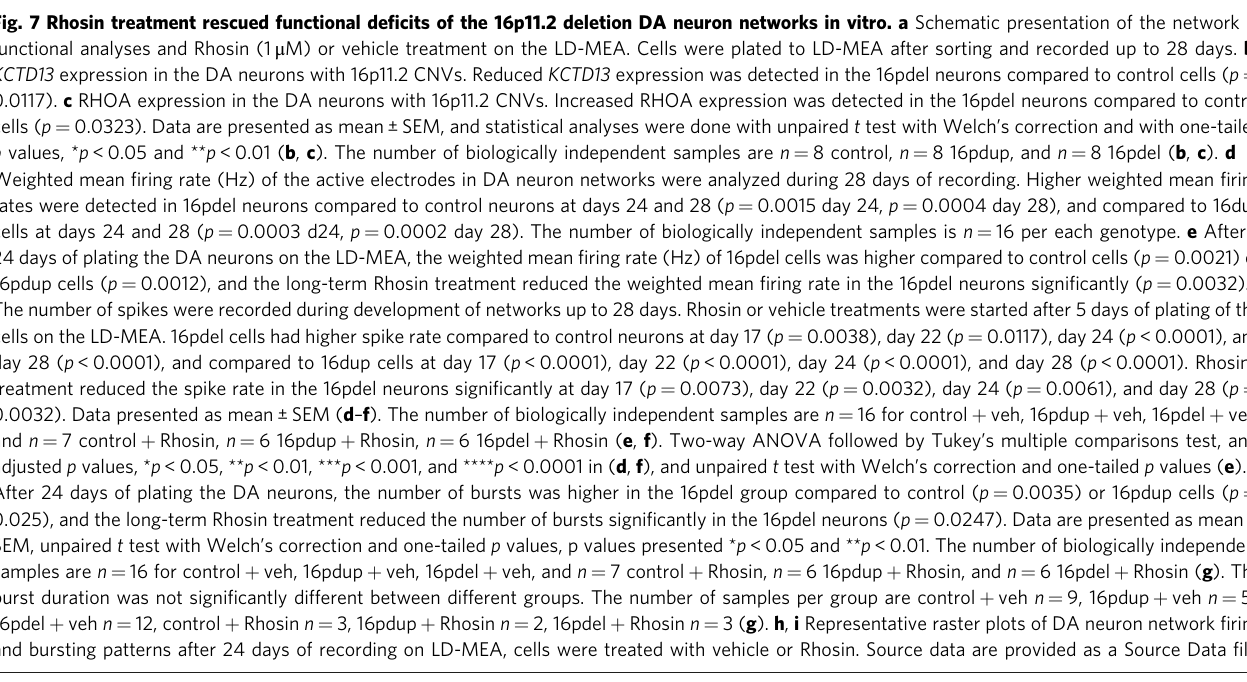
(Figs. 7c and 8b). We also measured Cullin3 expression in these cell populations and detected increased expression in the 16pdel neurons compared to controls (Fig. 8a, b), which indicates that reduction of KCTD13 plays a key role in the KCTD13 – Cullin3 in the 16pdel neurons. Previous studies had reported that het- usually leads to more prominent changes in protein expression and disease severity compared to cells with duplication of CNV duplication cells 45,46 . In line with this, we did not detect sig- ni fi cant changes in the protein expression in the 16pdup neurons compared to control cells (Fig. 7b, c).